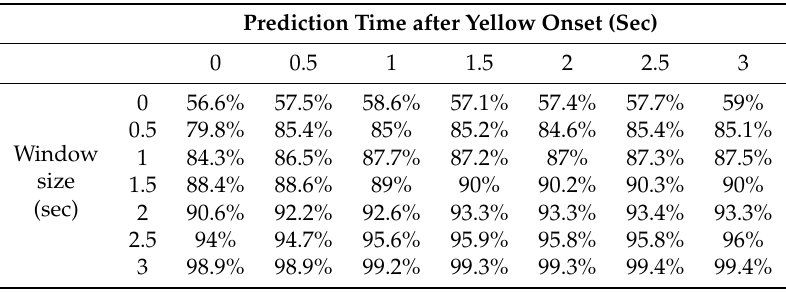
Table 2. Classification accuracy of Support Vector Machine (SVM) classifier.